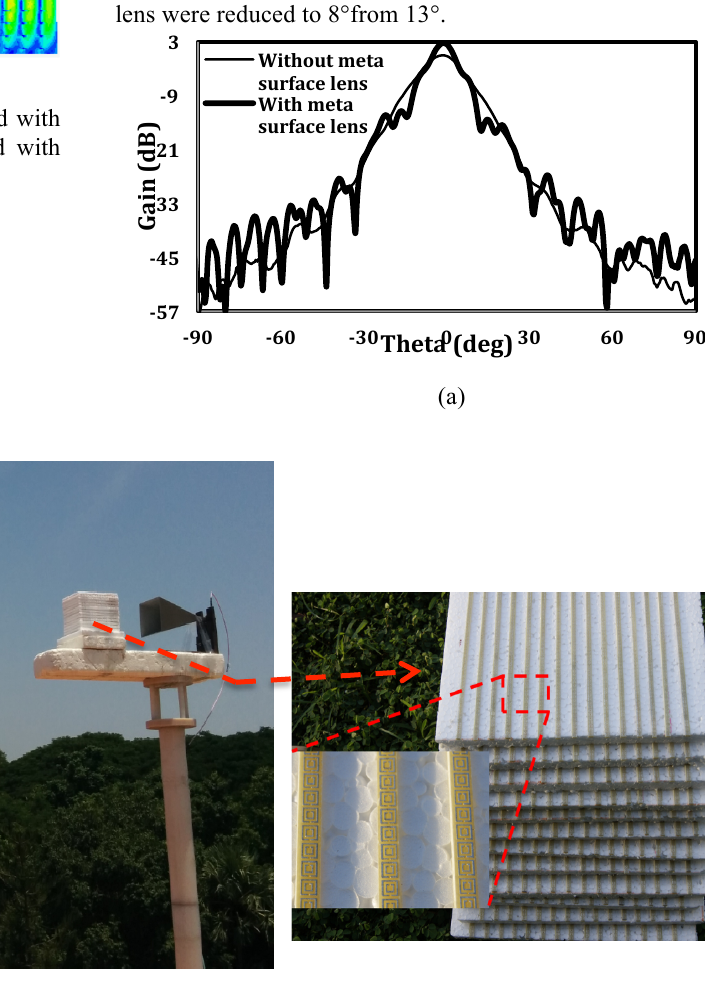
Figure 7: Open area Far field radiation pattern measurement. Top view of fabricated meta surface lens with array of SRR on fr4 strip. Each strip has 49 SRR elements and each layer has 15 strips. Similarly 11 layers are stacked to get 3D